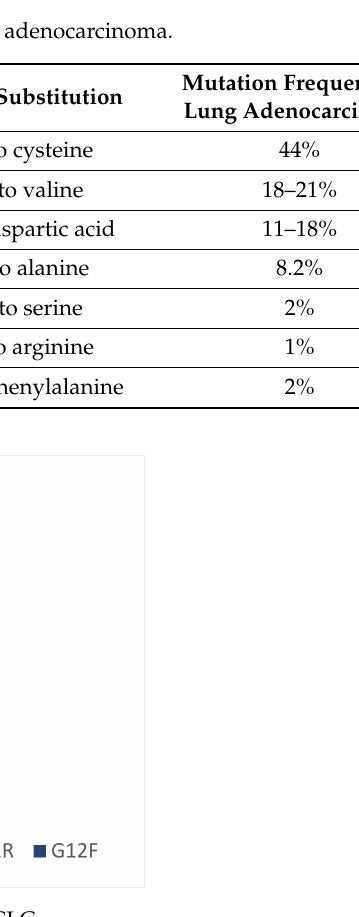
Figure 2. Incidence of KRAS mutation subtypes in